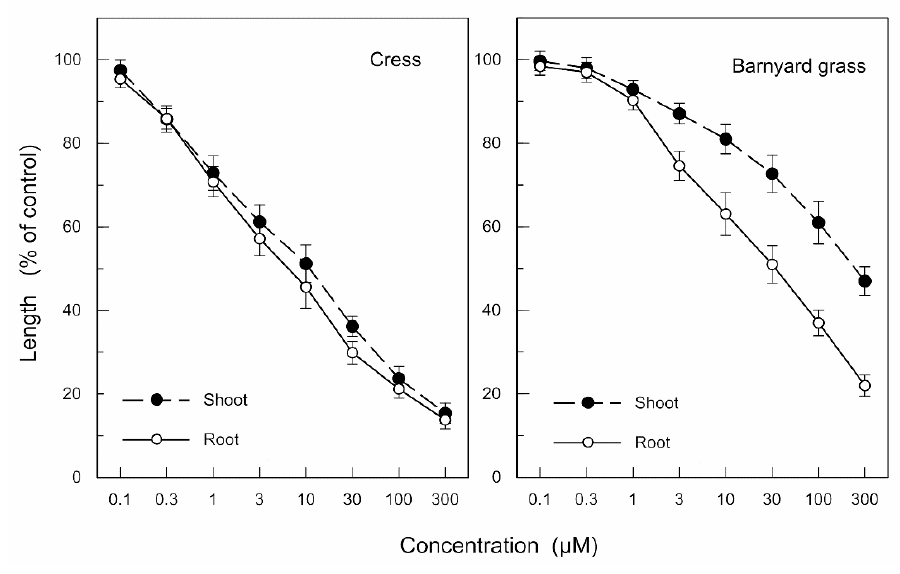
Figure 6. Effects of nimbic acid B on the root and shoot growth of cress and barnyard grass. Means ± SE from 4 independent experiments with 10 plants for each determination are